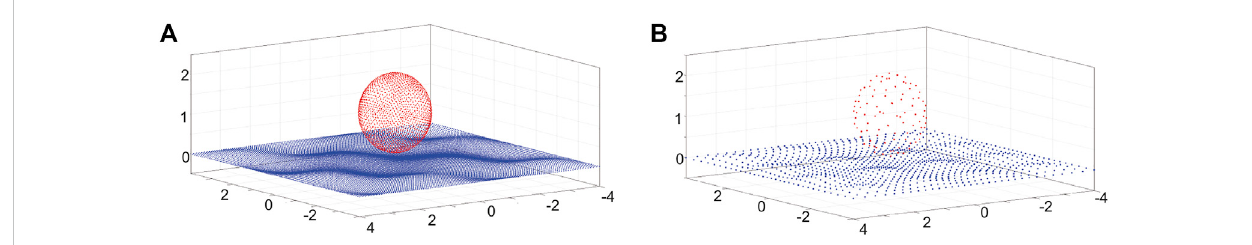
FIGURE 3 Illustration of the points representing the squirmer and surface topography, with the fi ner discretisation (A) used for the kernel and the coarser discretisation (B) , used for the surface traction. Discretisation points on the spherical squirmer surface are indicated by red dots. In contrast, blue discretisation points are shown for the doubly periodic surface topography of Figure 2B, with the size of the discretised surface given by L = 8 and the surface topography given by Eq. 5, as plotted in Figure 2B, with an amplitude of A = 0.1 and the wavelength given by λ = 2. Note that we here display the wall meshes after rescaling by the method described at the end of Section 3.